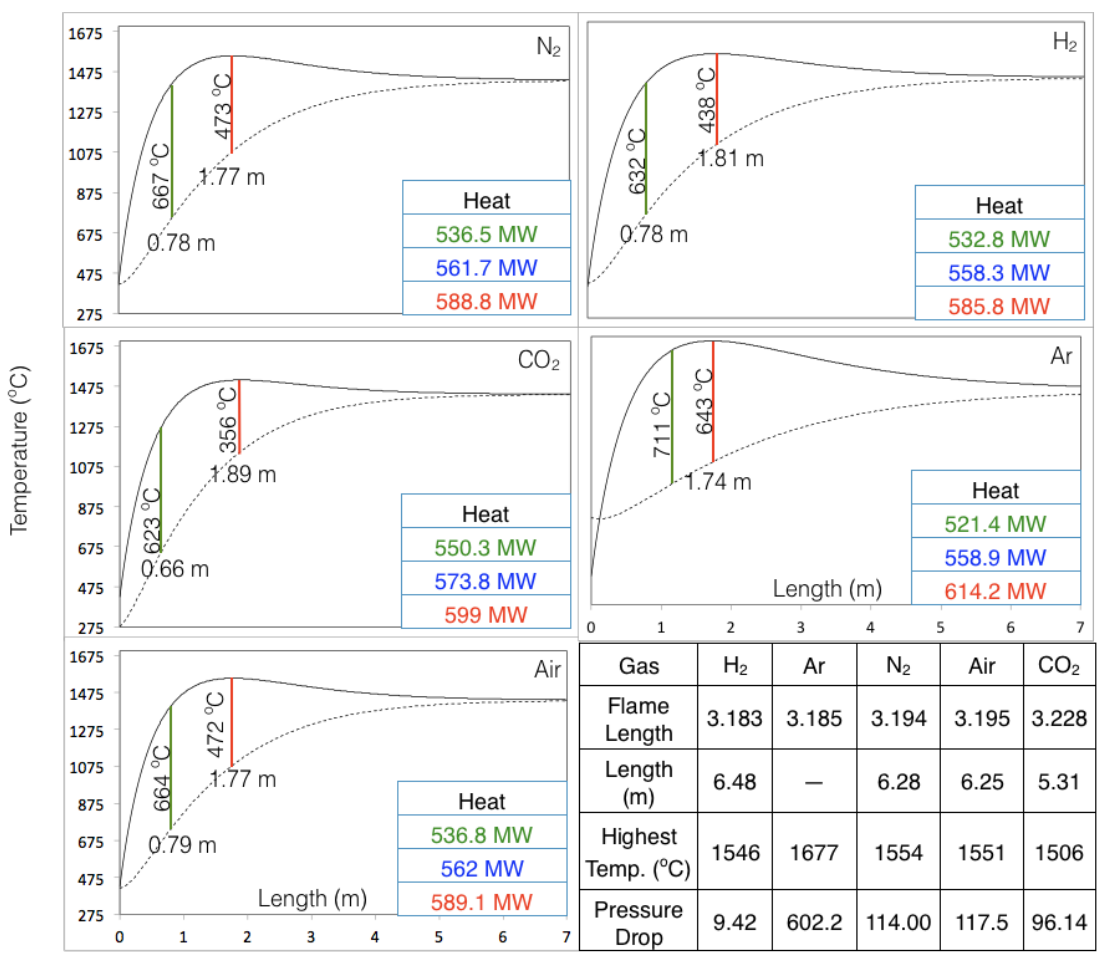
Figure 6. Temperature profiles in the combustor/heat exchanger at a mean adiabatic efficiency of 92.7%. Solid and dotted lines represent the main and partitioned fluid temperatures as a function of length, respectively, with a maximum error ±1 °C. Green and red lines represent the highest and maximum temperature gradient, respectively. Inset tables present the heat exchanged in the combustor; green, blue, and red represent the adiabatic efficiencies of 95.63%, 92.7%, and 89.9%, respectively.